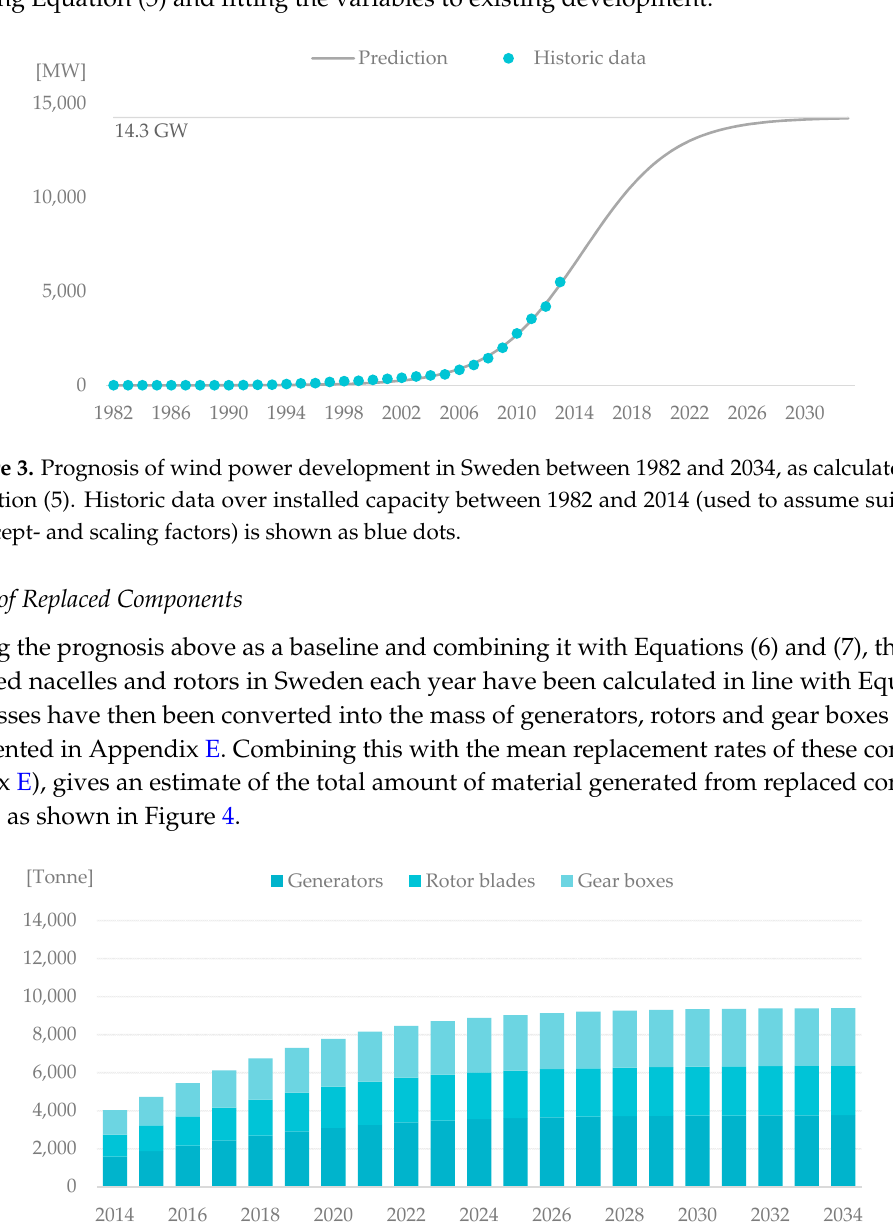
Figure 4. The predicted total mass of replaced generators, rotor blades and gear boxes on the Swedish wind power market between 2014 and 2034.